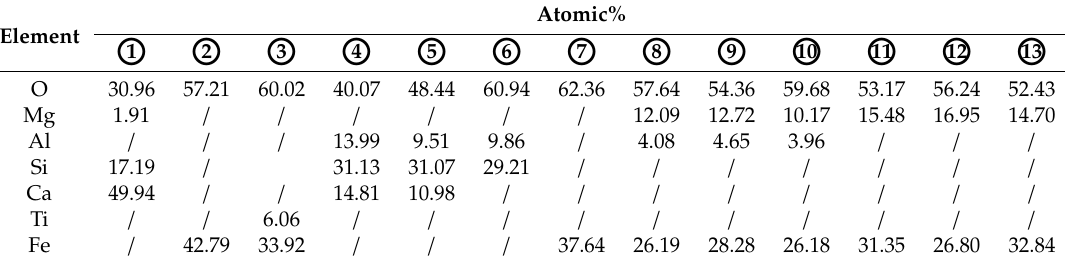
Figure 7. SEM images of the BG after the heat-treatment. ( a ) 890 °C; ( b ) 1100 °C; ( c ) 1190° C. Table 8. Chemical compositions of the crystalline phase in the BG.